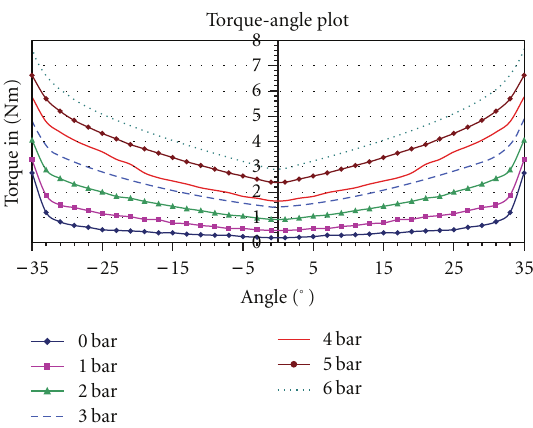
Figure 9: Torque plot of the actuator for internal